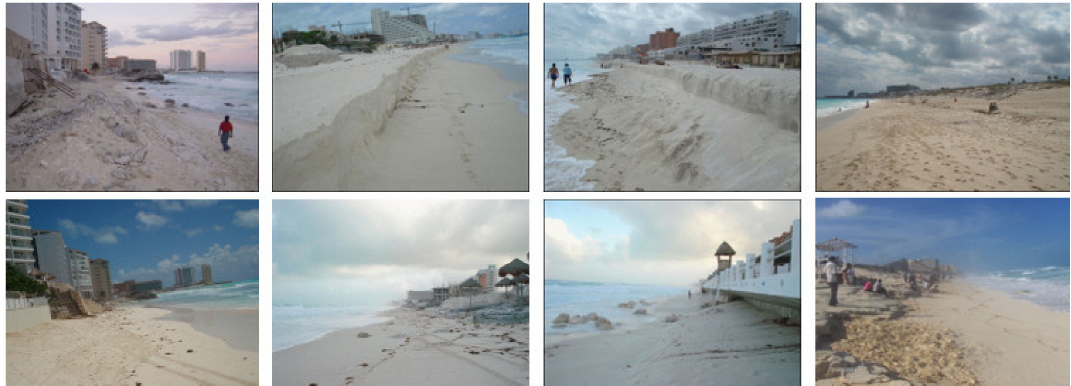
Figure 6. Examples of damage caused by Hurricane Dean to the beach of Cancun. Upper panels: August 15, 2007 (a few days before Hurricane Dean hit land), and lower panels: August 25, 2007 (a few days after Hurricane Dean had landed). Each photograph corresponds to approximately the same place in the upper and lower